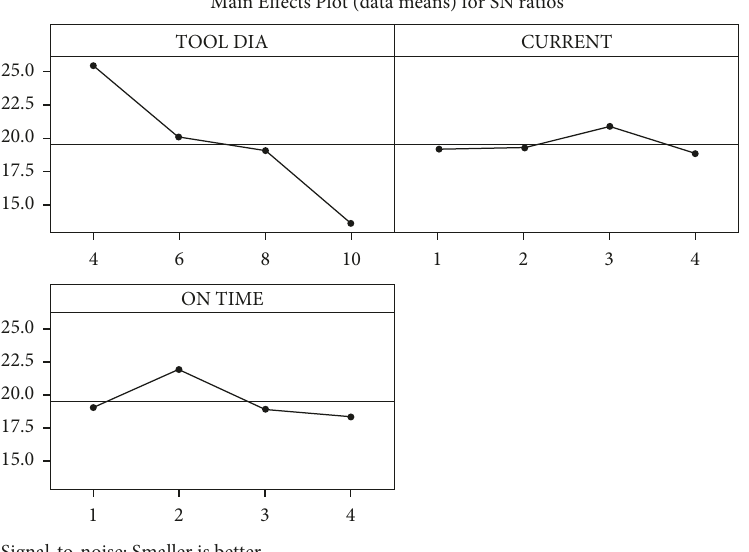
Figure 13: Main effect plot for mean. Main Effects Plot (data means) for SN ratios